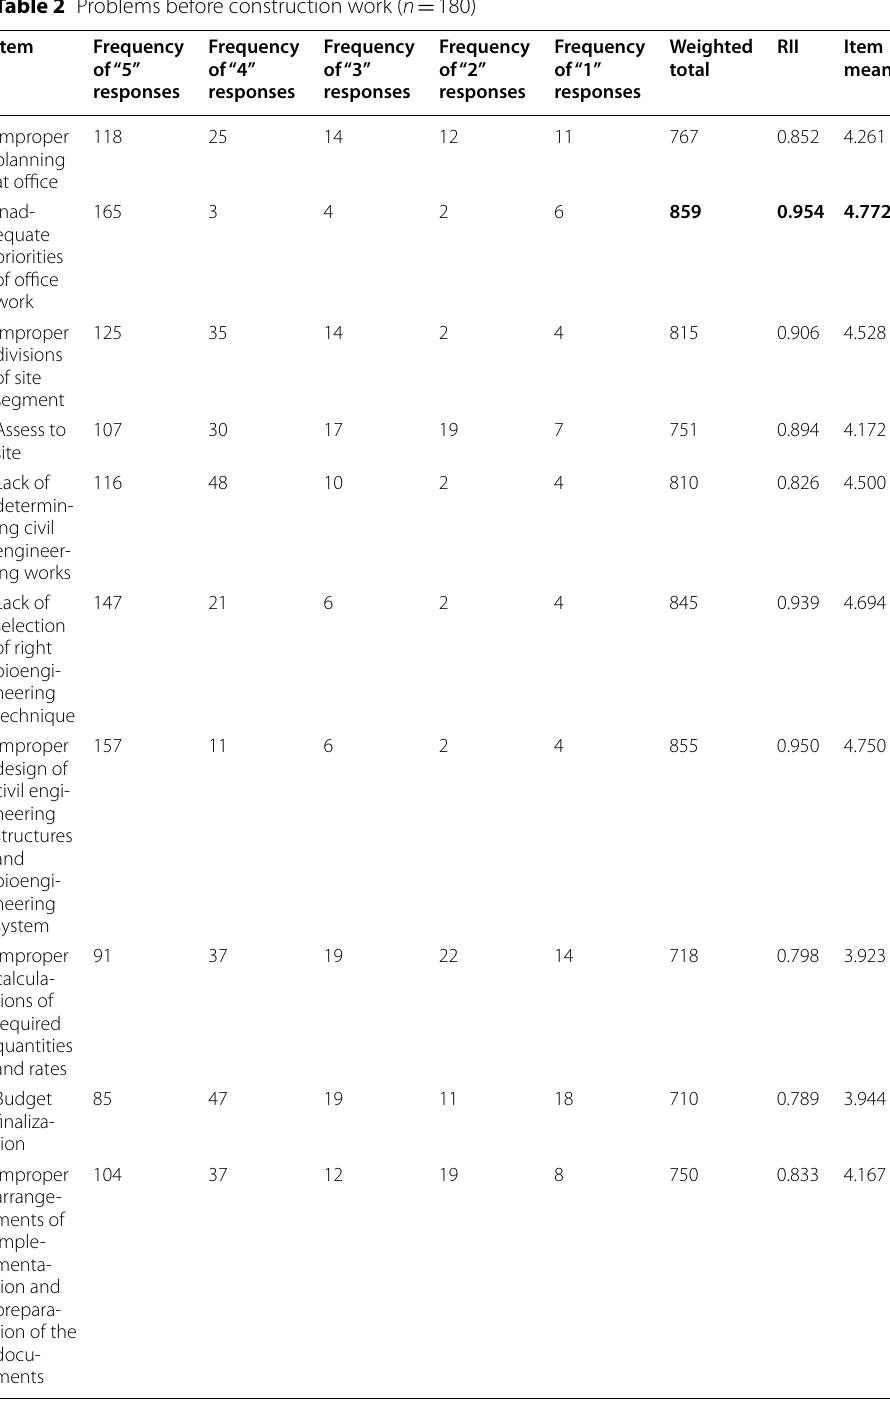
Table 2 Problems before construction work ( n